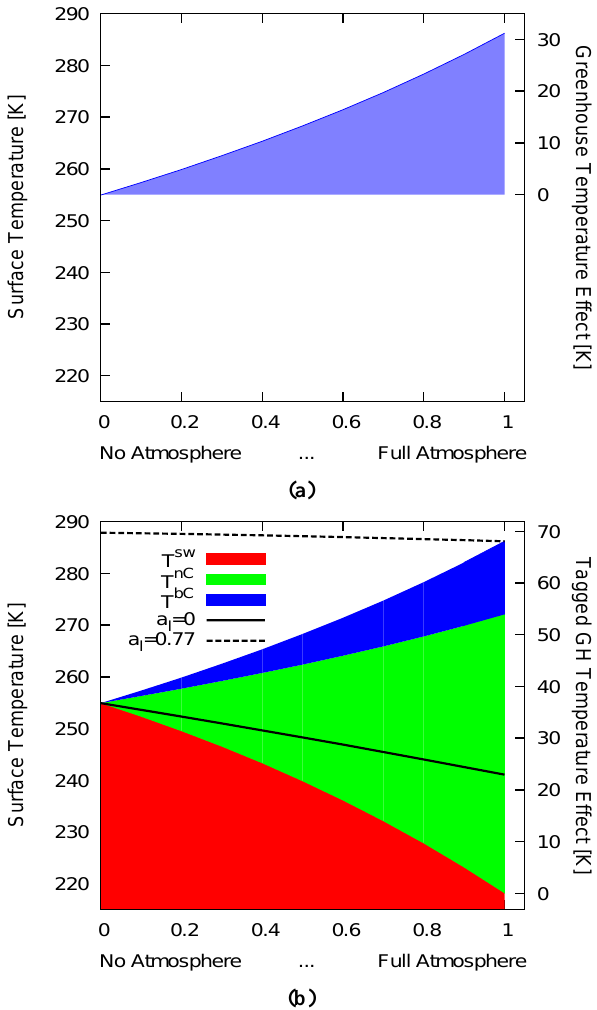
Fig. 2. Top: steady-state surface temperature (K) for the situation of no atmosphere ( = 0) to a full atmosphere ( = 1). In between the shortwave and longwave absorption are scaled. Bottom: as top but with additional information of the contribution of the longwave ab- sorption due to non-CO 2 greenhouse gases (“nC”, red) and CO 2 (“bC”, green). The temperature T sw s follows the lower edge of the red areas. Additionally two sensitivity experiments are included, where longwave absorption is excluded, which gives the effect of shortwave absorption on the surface temperature (solid line) and where longwave absorption is set to the “full atmosphere value” of a l = 0 . 77 (dashed